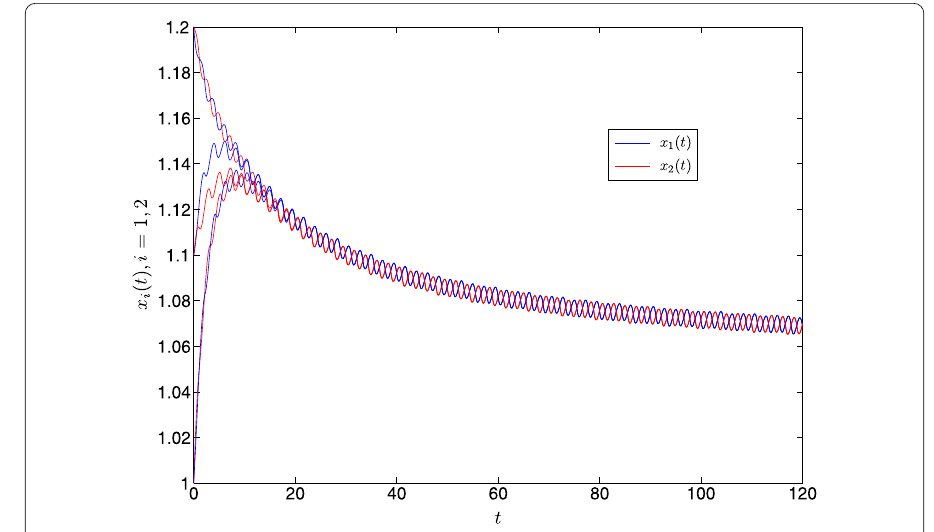
Figure 1 Trajectories of system (4.1) involving differential initial